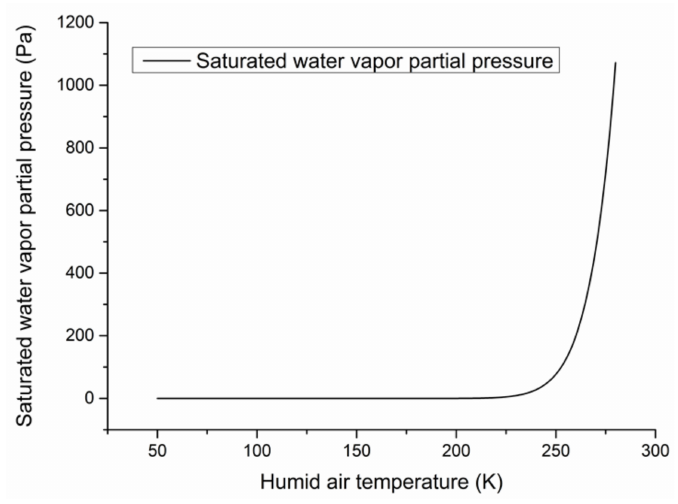
Figure 2. Variation of saturated water vapor partial pressure with